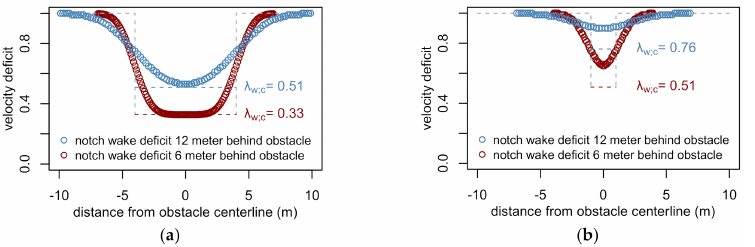
Figure 5. The concept of a Gaussian-shaped wake extending beyond a ( a ) wide obstacle of 8 × 8 × 10 m ( b ) narrow obstacle of 2 × 2 × 10